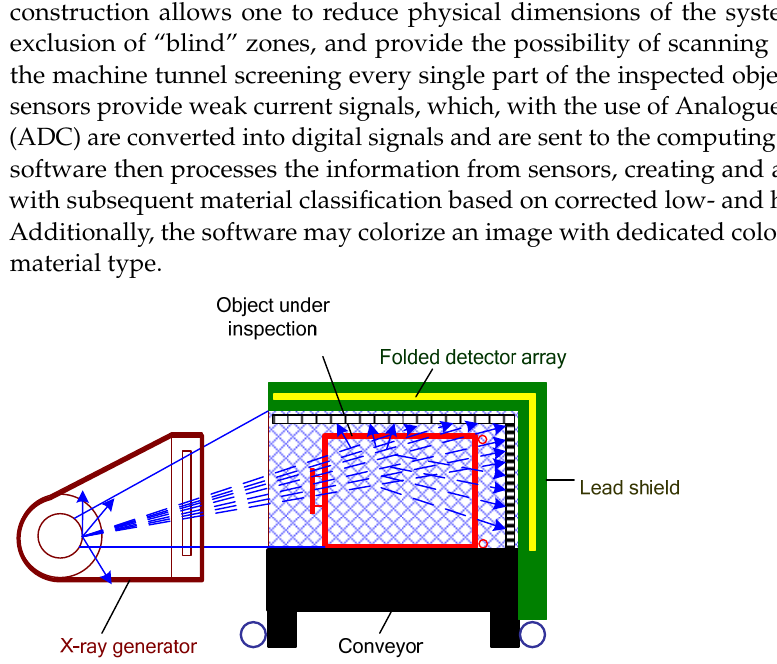
Figure 4. Schematic representation of a combined computed tomography system with a multiple energy X-ray source.